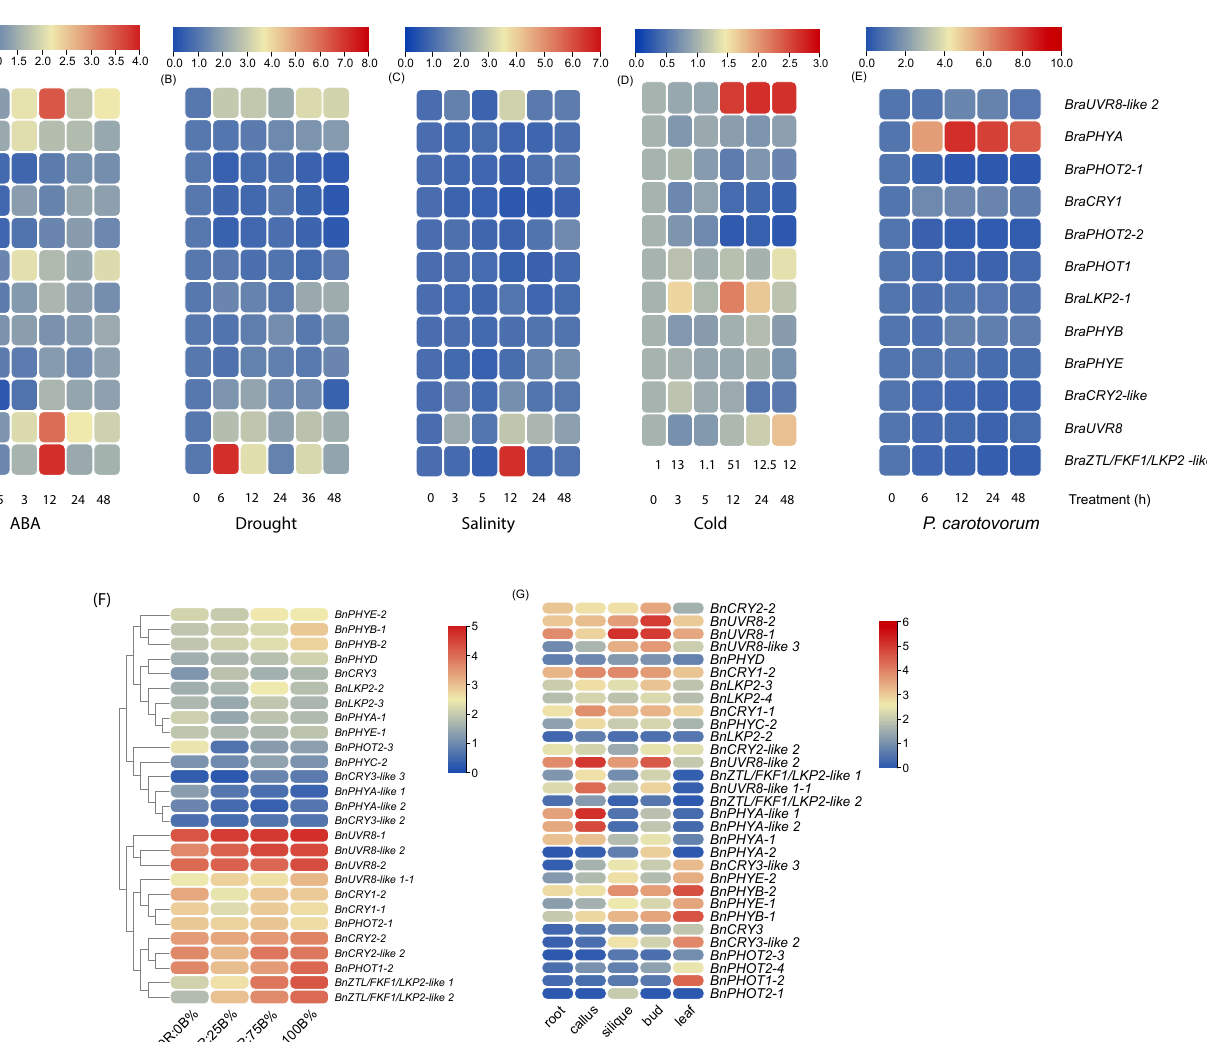
% % % % 0 B 25 B 100 B 75 B 100 R : 75 R : 25 R : 0 R : Figure 7. Transcriptional expression changes of photoreceptor ( PHR ) genes in stress conditions and in different tissue. ( A – E ) Heatmap representing the microarray-derived expression pattern (Log2FC) of B. rapa PHR transcripts in response to exogenous ABA, abiotic stress conditions (drought, salinity, and cold), and Pectobacterium carotovorum infections. ( F , G ) The RNA-seq data derived expression changes [Log2(FKPM)] of B. napus treated with different ratios of red (R)- and blue (B)-LED light conditions and in different tissue of B. napus (root, callus, silique, bud, and leaf).